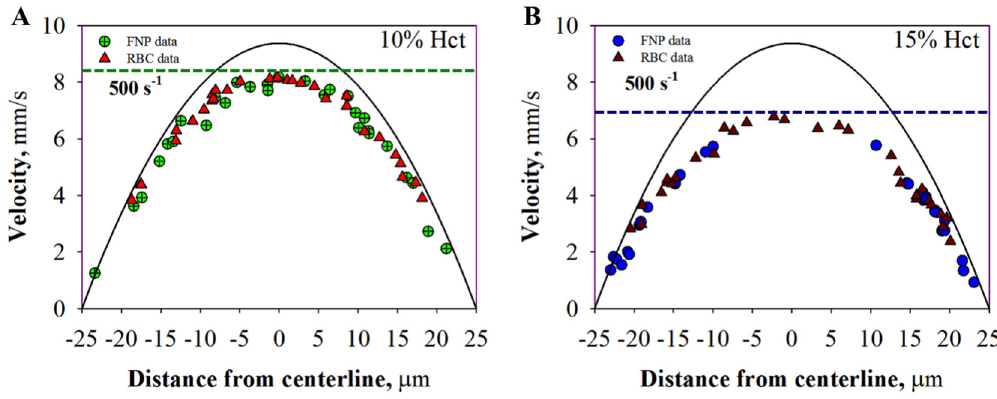
Figure 2. Velocity profile of RBCs (triangles) and FNPs (crossed circles) flowing in a glass microcapillary at 20 mmHg, corresponding to a wall shear rate of 500 s − 1 : ( A ) FNPs (green crossed dots) and RBC (red triangles) experimental velocity profile at Hct 10%; and ( B ) FNPs (blue crossed dots) and RBC (dark red triangles) experimental velocity profile at Hct 15%. (For interpretation of the references to color in this figure legend, the reader is referred to the web version of this article.)